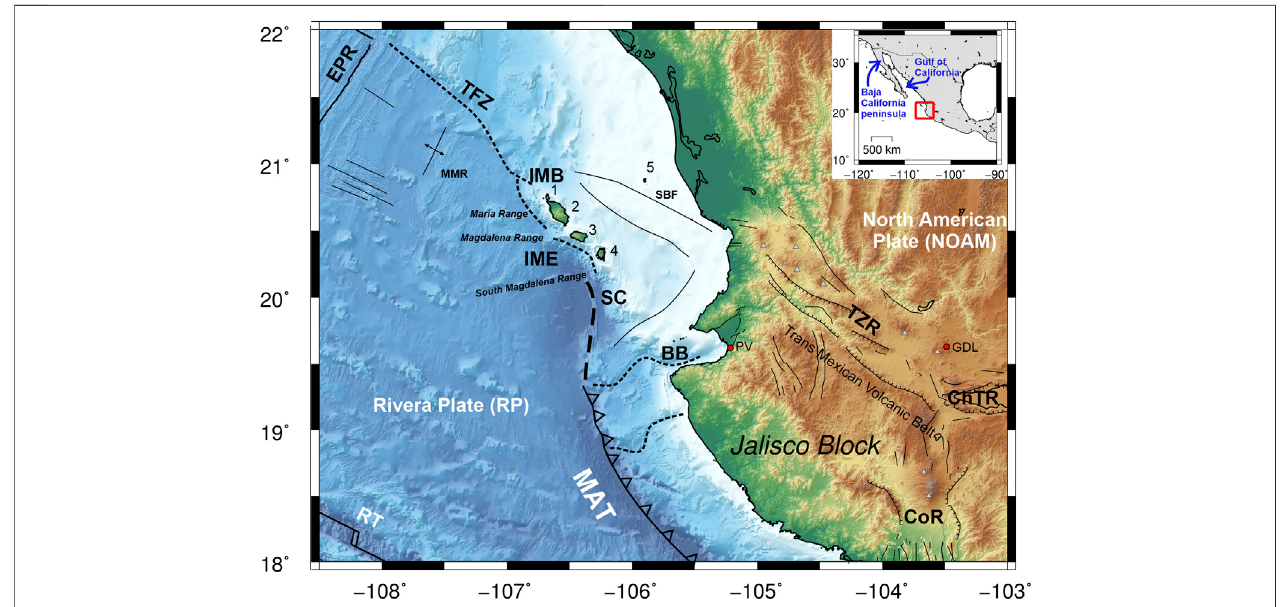
FIGURE1| TopographicmapandtectonicsettingofthewesternMexicanregion. Abbreviations : BB ,BahíadeBanderas; CoR ,Colimarift; ChTR ,Chapala-Tularift; EPR ,EastPaci fi cRise; GDL ,Guadalajara; IMB ,IslasMaríasBlock; IME ,IslasMaríasEscarpment; MAT ,MiddleAmericatrench; MMR ,MaríaMagdalenaRise; PV ,Puerto Vallarta; RT ,RiveraTransform; SBF ,SanBlasfault; SC ,SierradeCleofas; TFZ ,Tamayofaultzone; TZR ,Tepic – Zacoalcorift; 1 ,SanJuanitoIsland; 2 ,MaríaMadreIsland; 3 , María Magdalena Island; 4, María Cleofas Island; 5 , Isabel Island. ( Inset ) Location map of the study area within the North American continent.